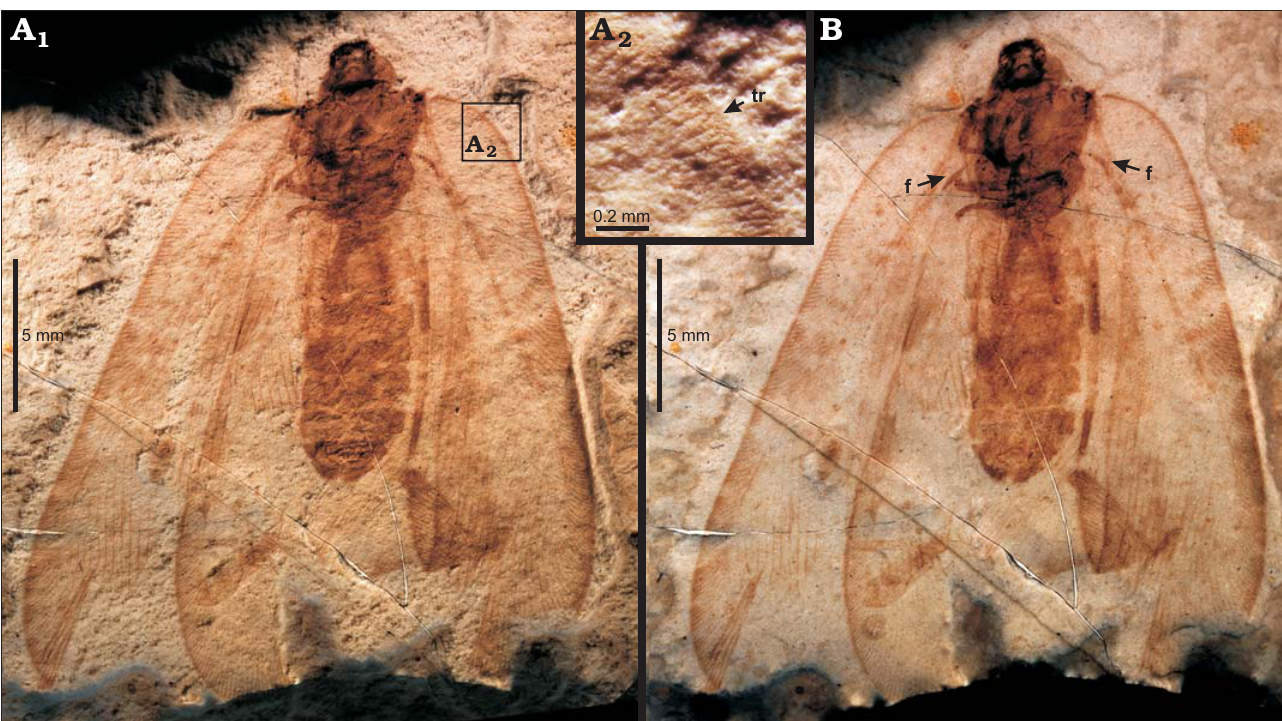
Fig. 1. Moth lacewing Guithone bethouxi gen. et sp. nov. holotype (CNU-NEU-NN2015003P/C) from Bathonian–Callovian boundary (Middle Jurassic) of Jiulongshan Formation of Daohugou, China. Photographs: dry-ethanol ( A ) and ethanol-ethanol ( B ) composites; detail (A